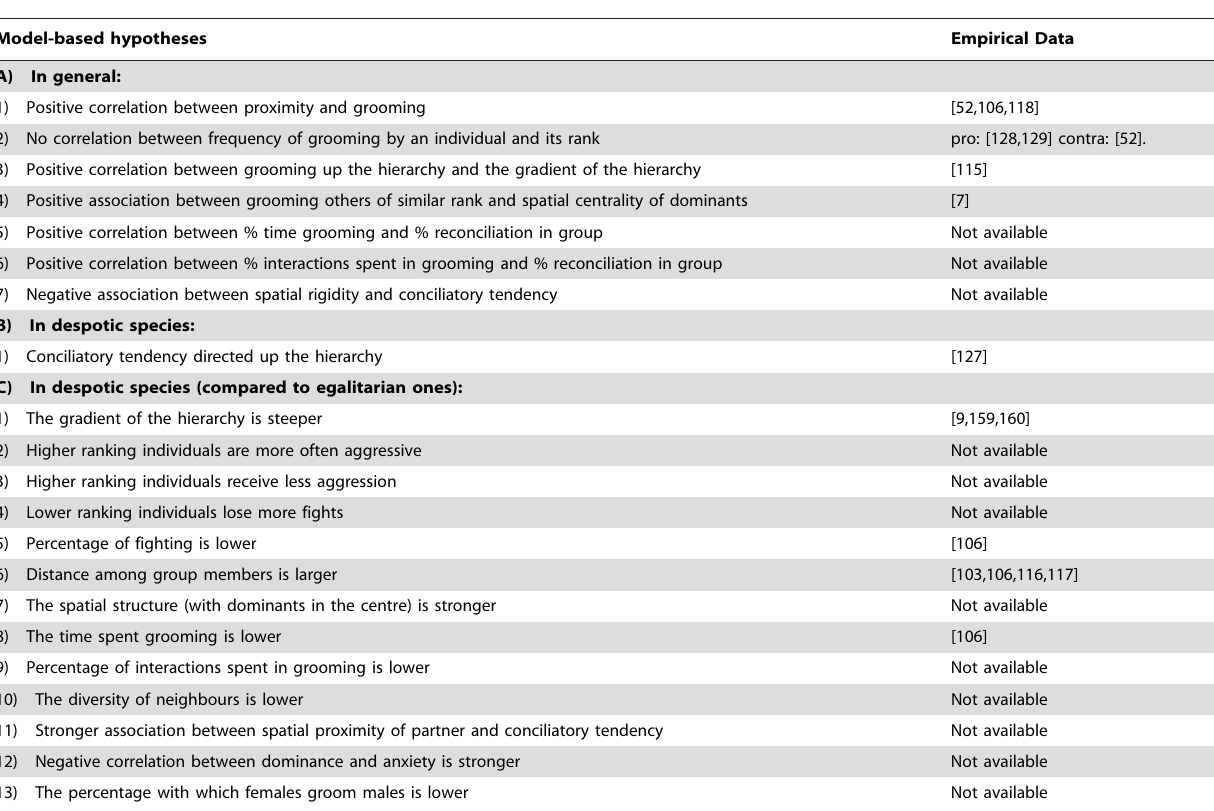
Table 2. List of model based hypotheses that emerge in the